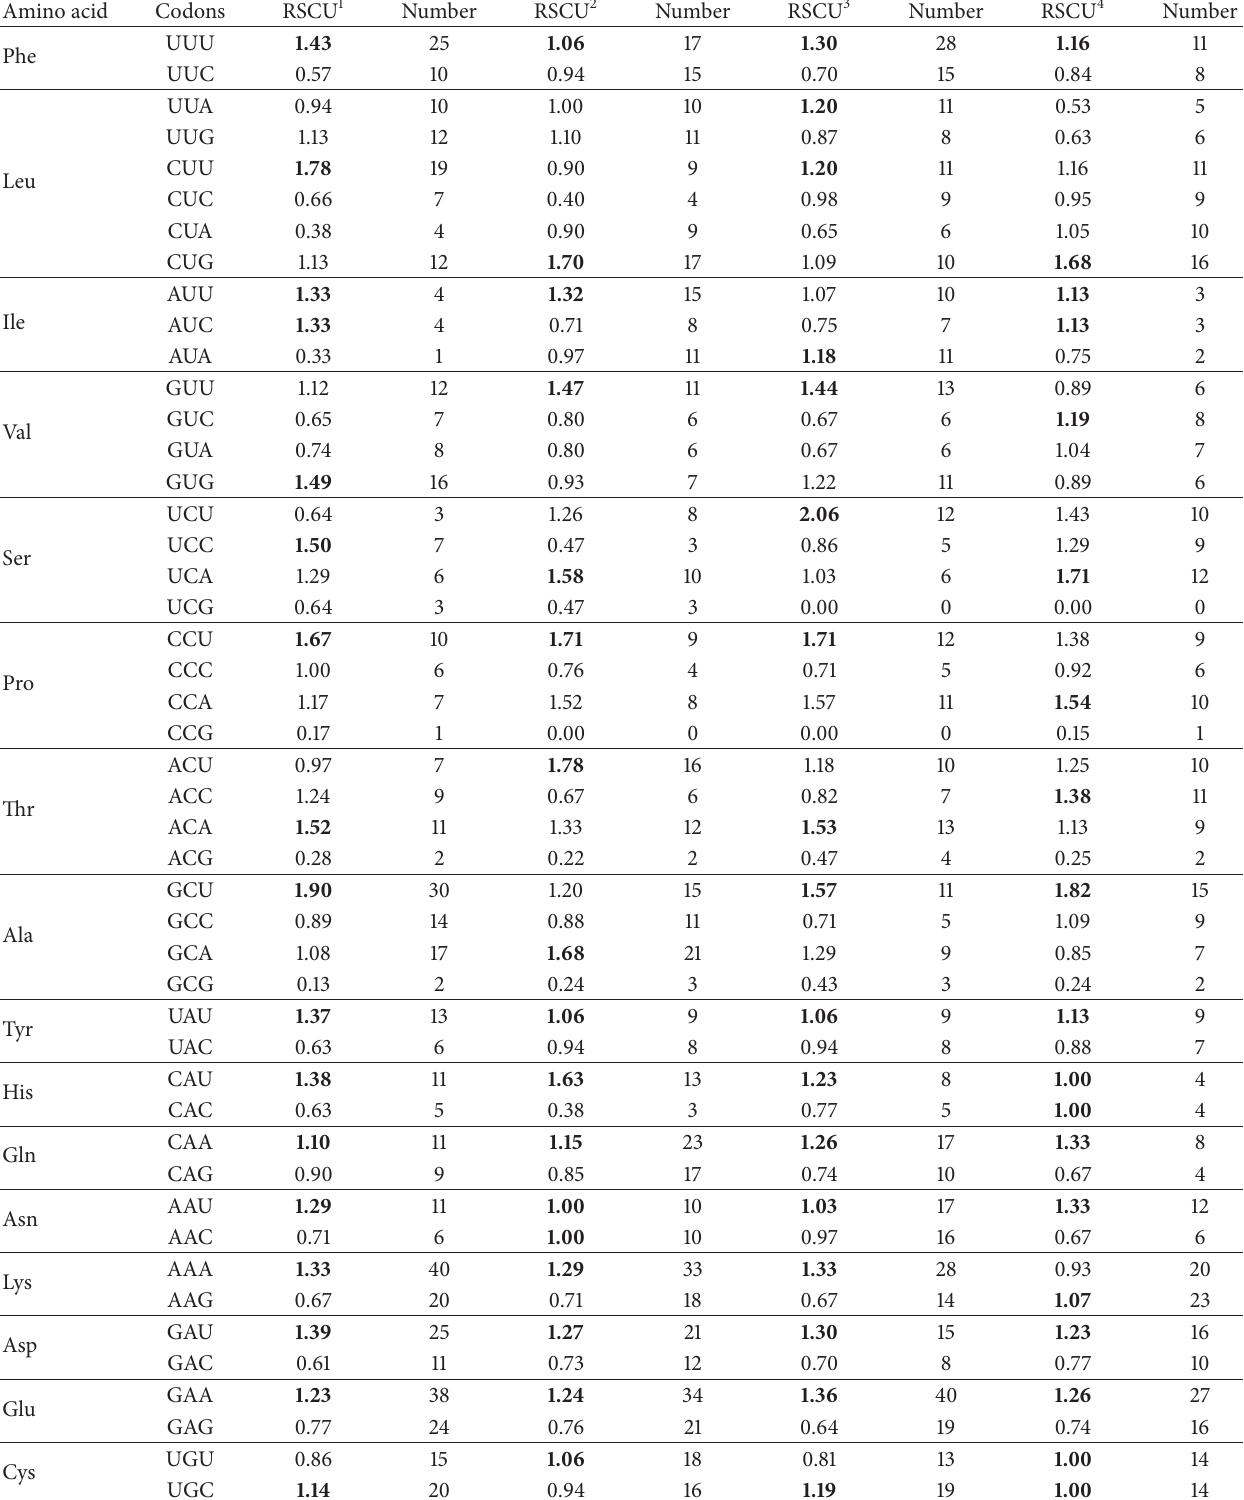
Table 3: Relative synonymous codon usage in human albumin superfamily members. The value in bold indicates the codons used with high